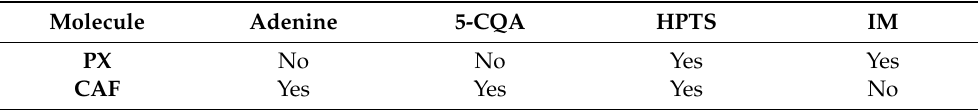
Table 2. Interactions of adenine, 5-caffeoylquinic acid (5-CQA), 8-hydroxypyrene-1,3,6-trisulfonic acid trisodium salt (HPTS), and imidazole (IM) with paraxanthine (PX) and caffeine (CAF). ‘Yes’ indicates evidence of strong interactions. ‘No’ suggests absence of any significant